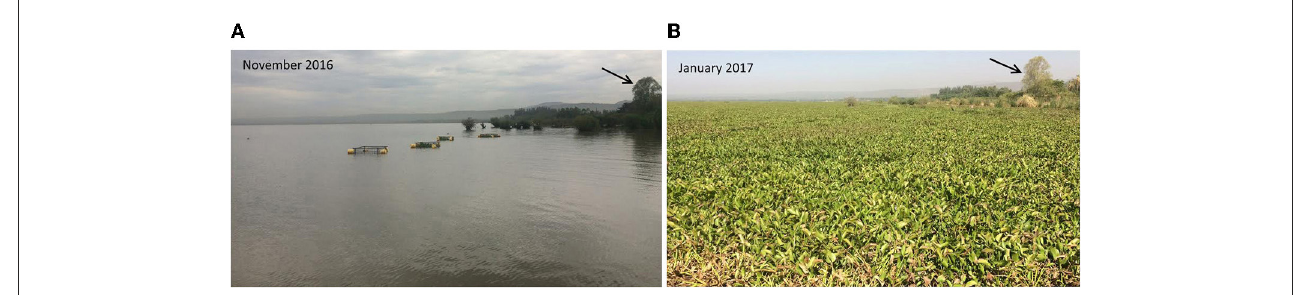
FIGURE2 Comparison of ambient water hyacinth density in (A) November 2016 and (B) January 2017. Placement of experimental cages can be seen in (A) . Note that while November 2016 is during one of the seasons investigated (WET16), (B) is not, but is included to represent typical high water hyacinth coverage